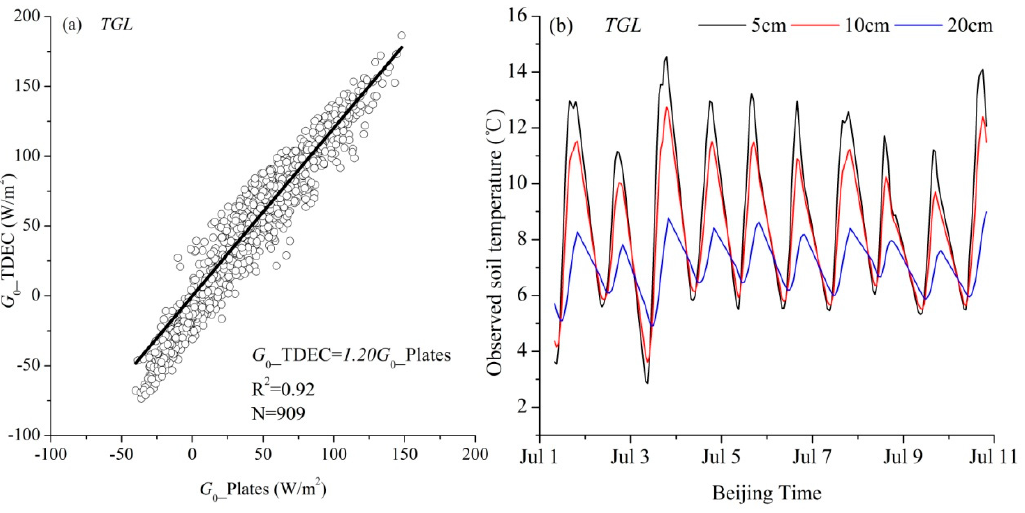
Figure 3. Linear relationship between G 0 _TDEC and G 0 _Plates ( a ) and the temporal variation characteristics of soil temperature at the TGL site, at depths of 5 cm, 10 cm, and 20 cm ( b ).